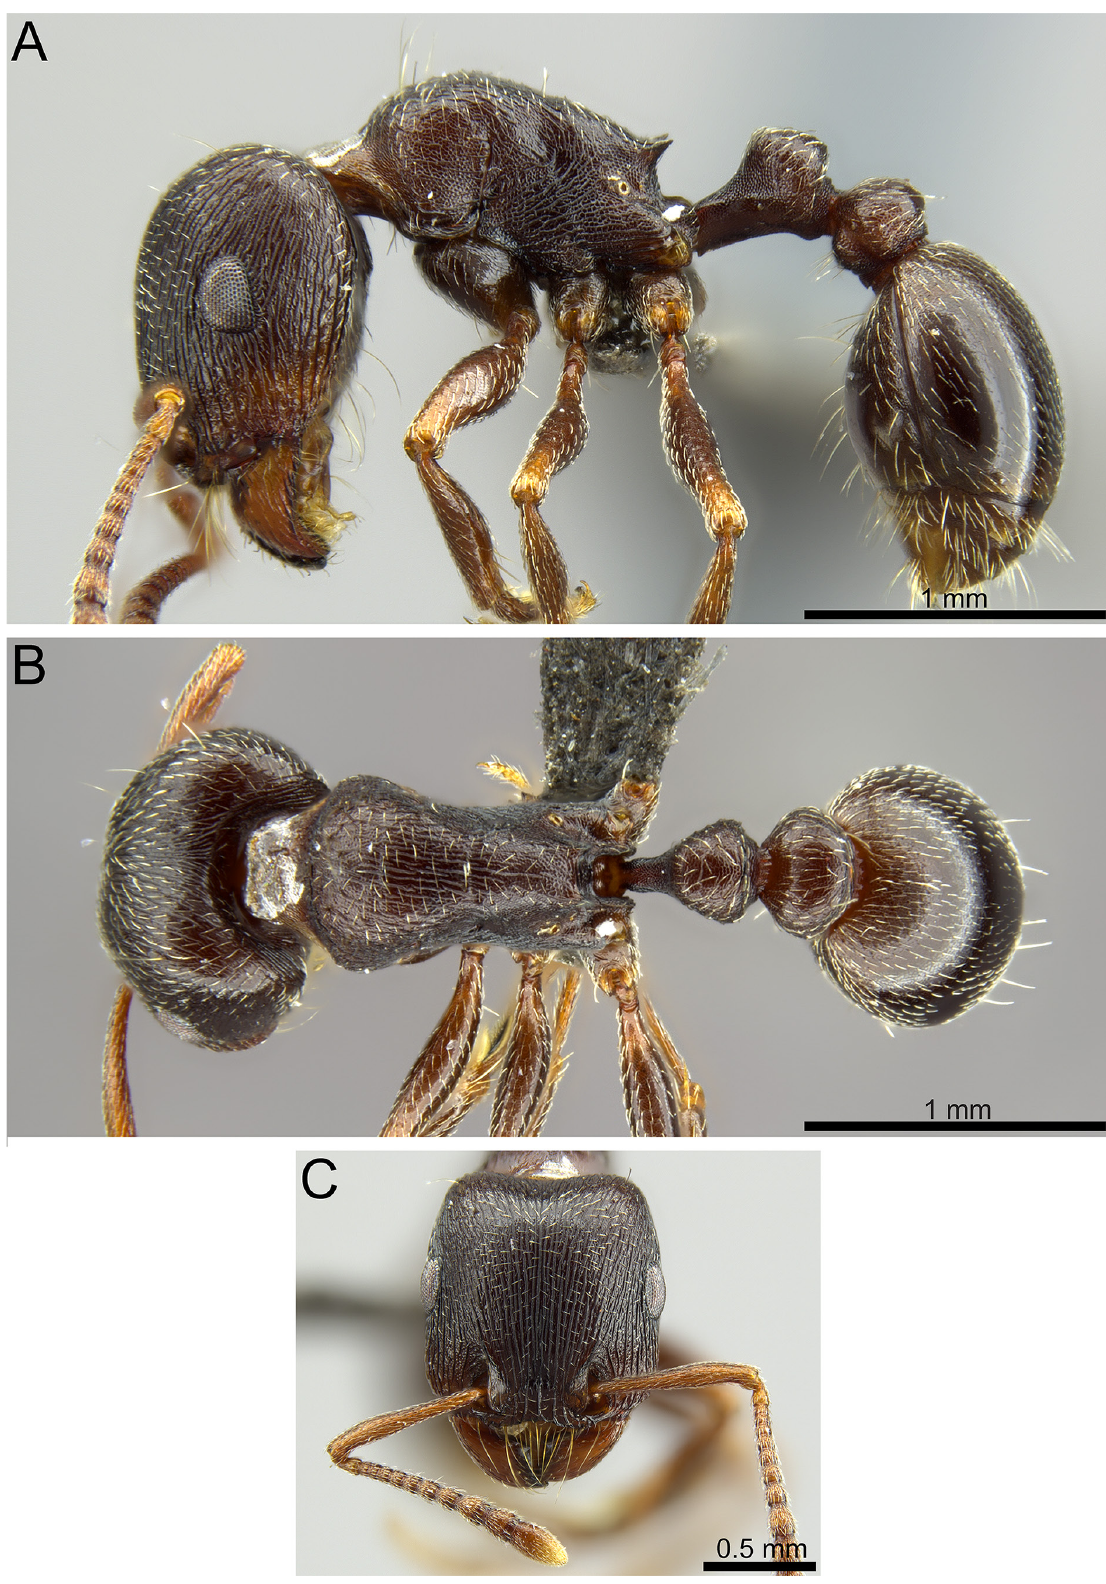
Fig. 5. Tetramorium aisha Mbanyana, Robertson & Hita Garcia sp. nov. (CASENT0250969). A . Body in profile. B . Body in dorsal view. C . Head in full-face